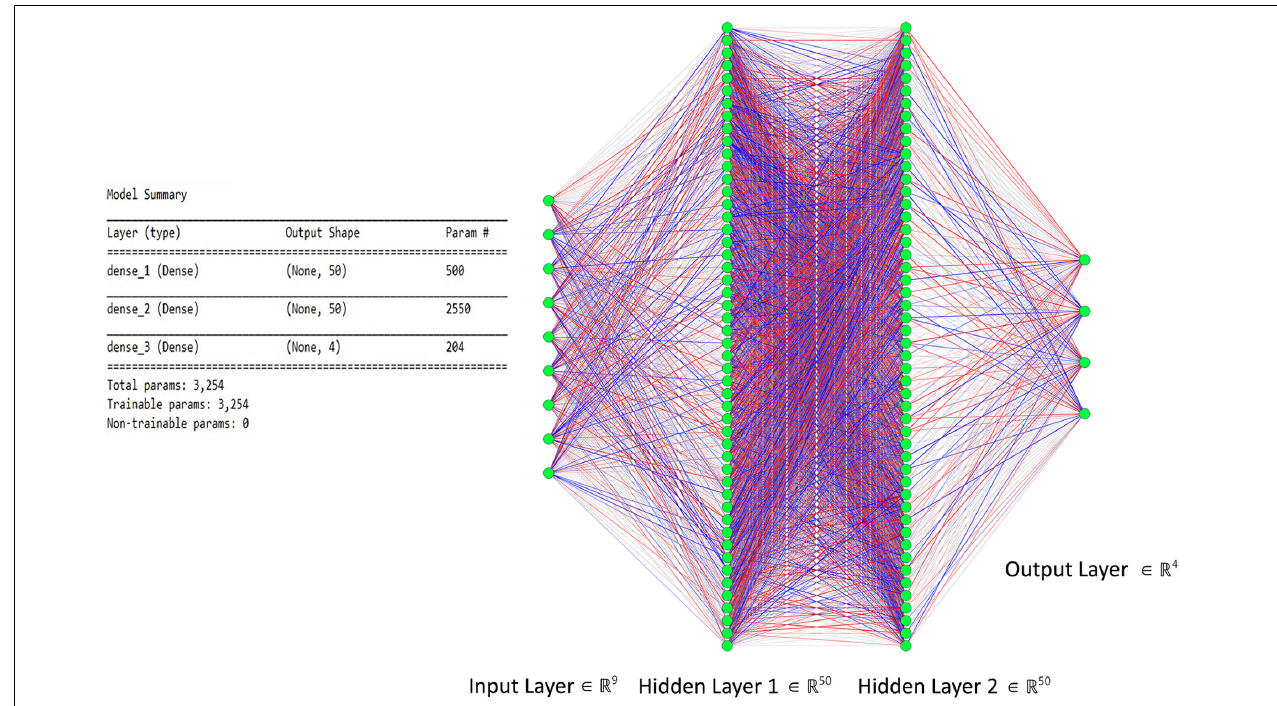
FIGURE 6 | The proposed artificial neural network (ANN) model with two hidden layers used for classification.